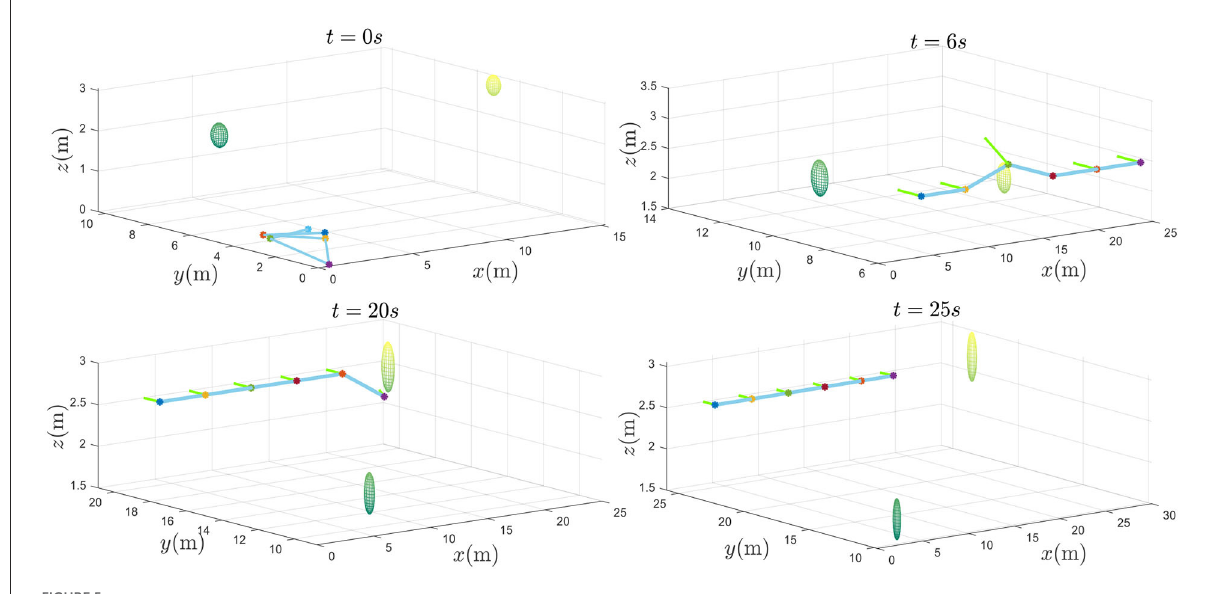
FIGURE5 The multiple plant protection UAVs system flight process.